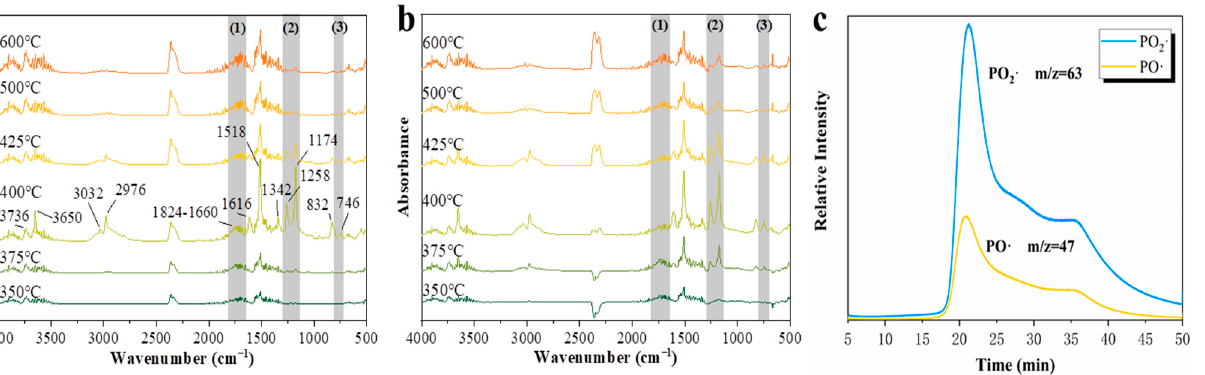
Figure 6. FTIR spectra of volatile pyrolysis products of EP ( a ) and 2%HPDAl/EP ( b ) at different temperatures, TG-FTIR-GC/MS curves of PO· and PO 2 · from HPDAl ( c ).